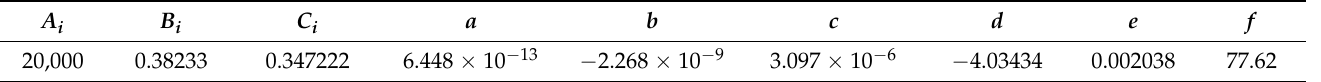
Table 3. The material property constants and the model coefficients of the air-cooled SCC specimens.